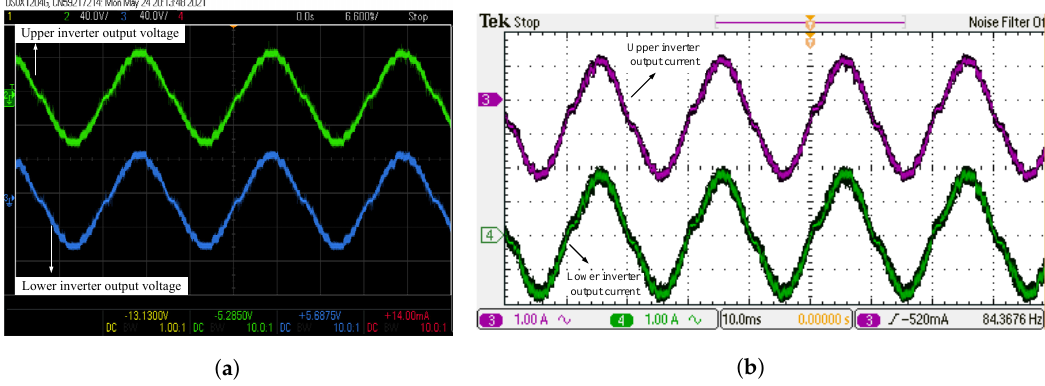
Figure 11. Measured waveforms of the multi-converter system with a common DC-bank ( a ) output voltages ( b ) output currents—two inverter units interleaved at θ fsw _2 = 0 ◦ , and θ fsw _2 = 90 ◦ , using parameters in Table